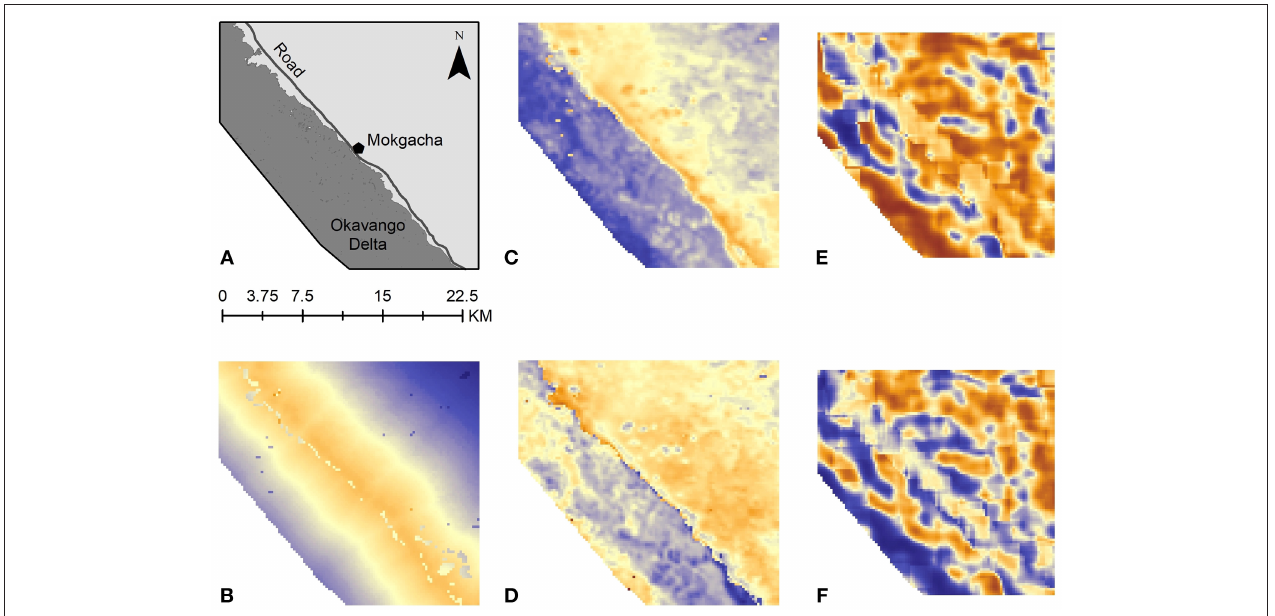
FIGURE 4 | Predicted surfaces generated from resource selection models. The color ramp scales from negative selection values in blue to positive selection values in orange. Coefficients and covariates used to create these surfaces are reported in Table 2 . (A) Reference key for region and scale, showing location of Mokgacha, the main road, and the Okavango Delta; (B) Human resource selection map for firewood collection; (C) Nighttime elephant resource selection map; (D) Daytime elephant resource selection map; (E) Map of Spearman’s correlation coefficients calculated between the firewood collection map and the nighttime elephant resource selection map, using a 9 × 9 moving window; (F) Map of Spearman’s correlation coefficients calculated between the firewood collection map and the daytime elephant resource selection map, using a 9 × 9 moving